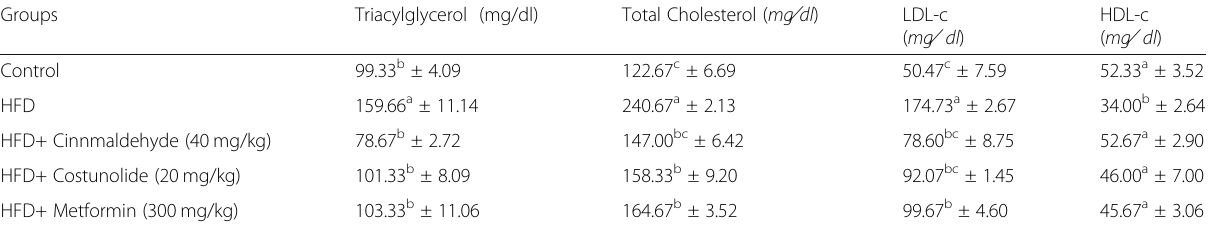
Table 4 Effect of oral administration of cinnamaldehyde and costunolide on serum lipids levels in HFD fed rats for 30 days